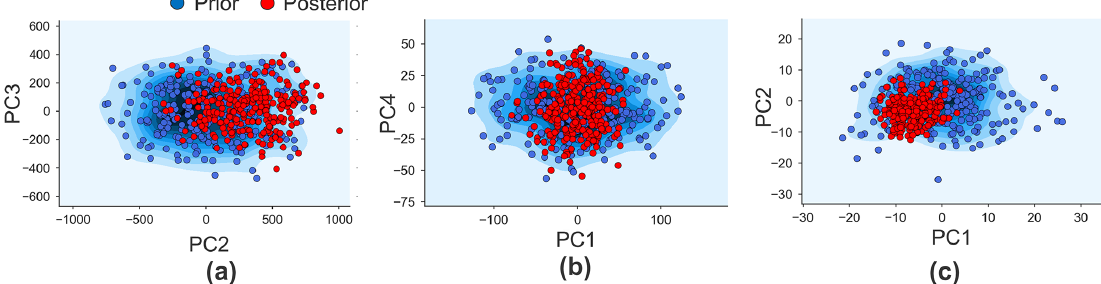
Figure 17. Prior and posterior distribution of the scores of the two sensitive PCs with highest variances: (a) porosity, (b) log-perm, and (c)